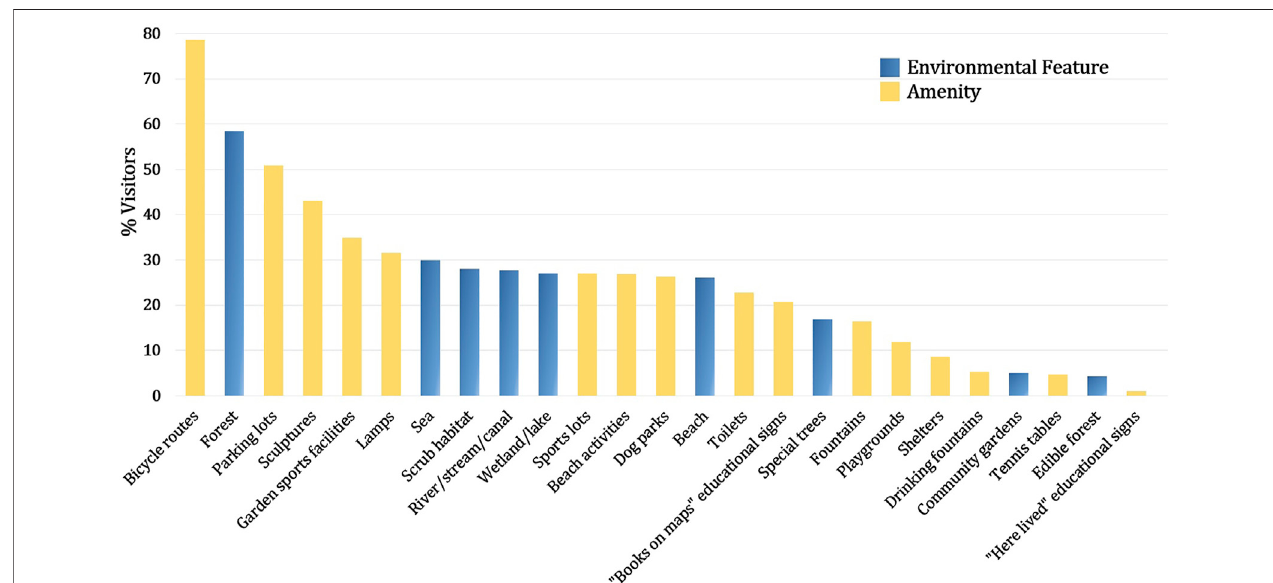
FIGURE 3 | Environmental features and amenities of urban nature sites by percentage of visitors.